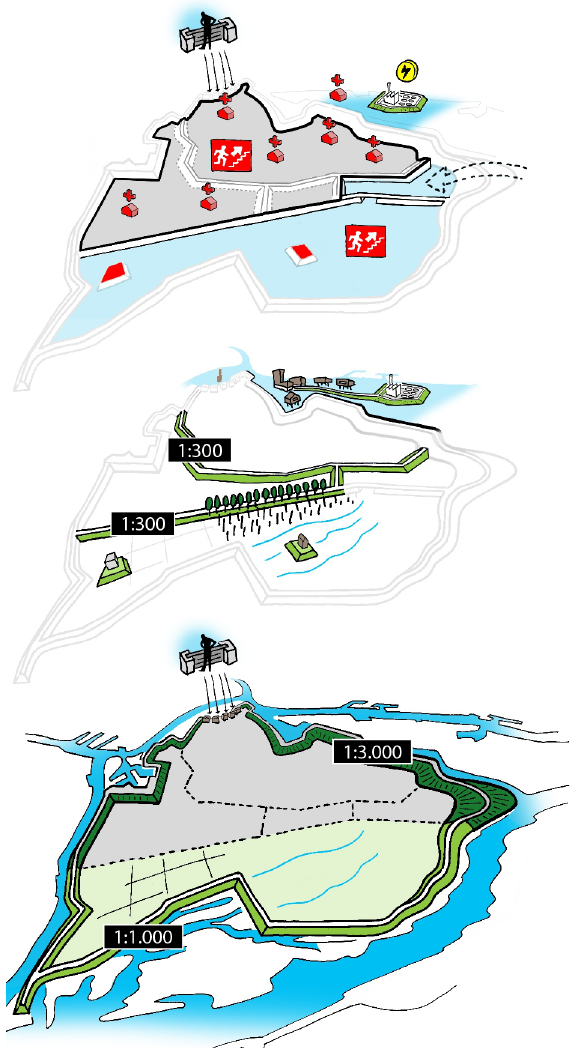
Fig. 2 . Visualization of the resilient strategy (courtesy: De Urbanisten). This strategy consists of vertical evacuation to higher floors and shelter locations (above), compartmentalization by restoring the regional flood defences (middle), and an adjustment of the legal standard for the primary flood defences (below).